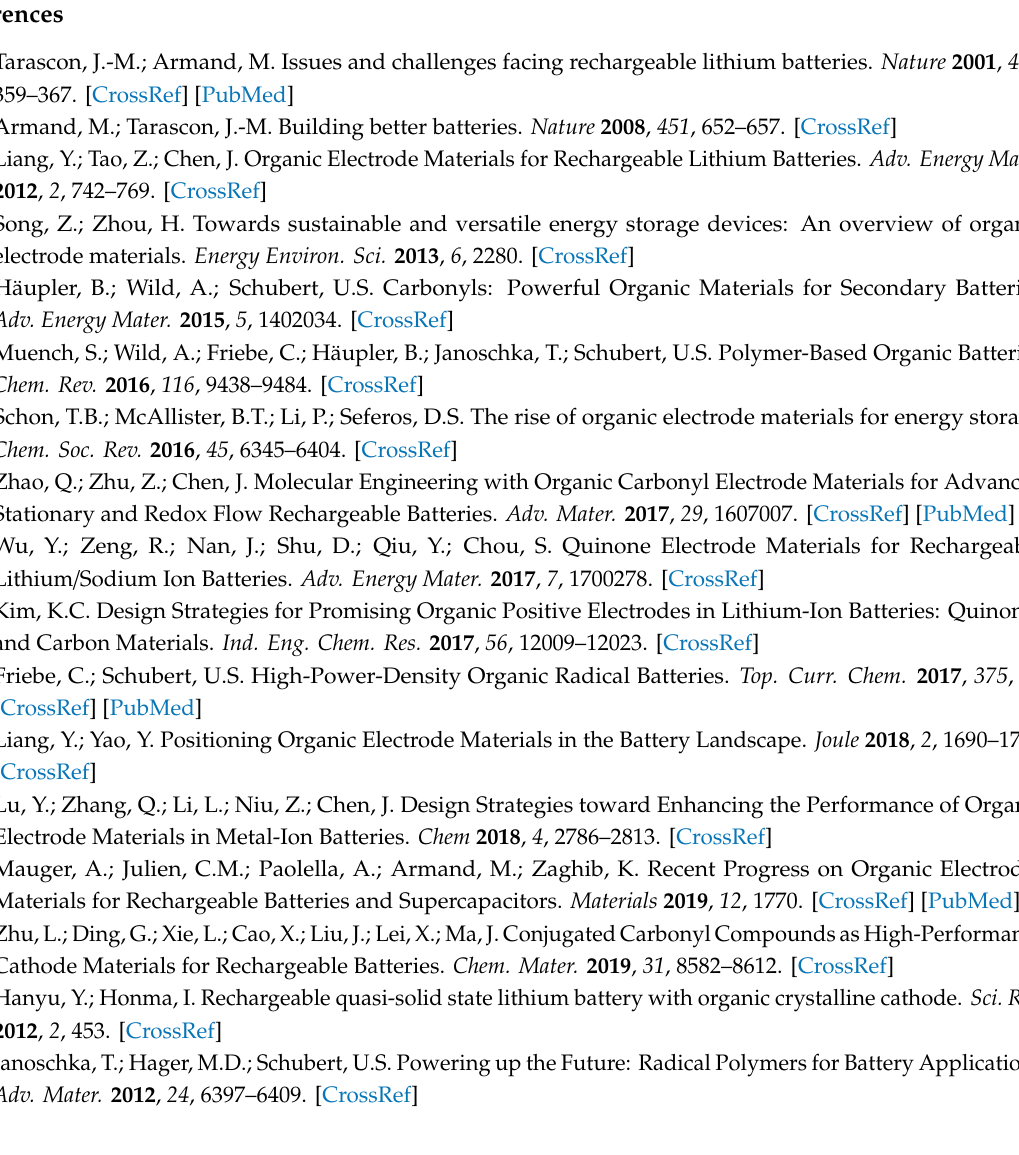
Figure S1: 1 H NMR spectrum of [( n -Hex ) 4 N + ]( 4 − ) in DMSO- d 6 , Table S1: Intramolecular C–C and C–O bond lengths (Å) and dihedral angles ( ◦ ) between TOT and pyridyl moieties of 4 − in the crystal structures, Figure S2: Cyclic voltammogramsof[( n -Bu ) 4 N + ( 1 − )and[( n -Hex ) 4 N + ]( 4 − )inDMF,FigureS3: Asymmetricunitinthecrystalstructure of [( n -Hex) 4 N + )]( 4 − )(H 2 O) 2.5 (DME) 0.5 , Figure S4: Molecular structure in [Zn 2 + ( 4 − )(DMSO) 2 ](NO 3 − )(solvent) x